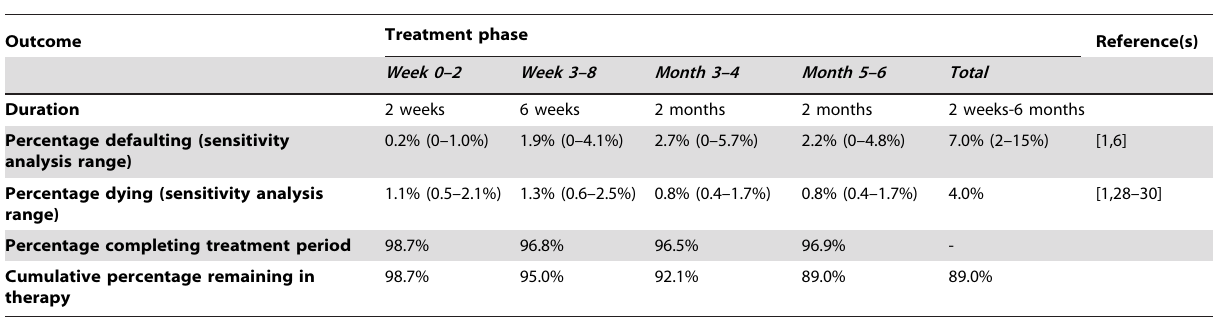
Table 1. Model inputs for TB treatment outcomes, by treatment phase.